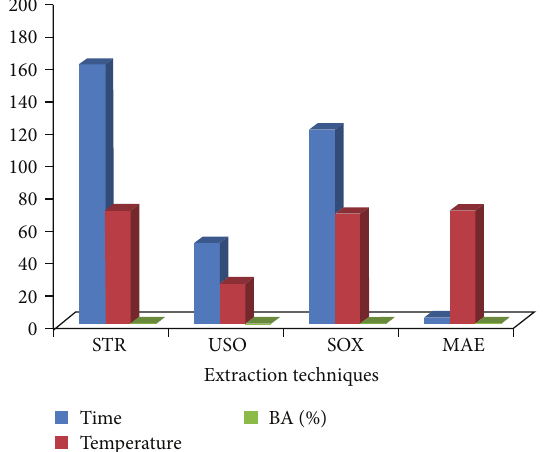
Figure 9: The effect of stirring extraction with methanol at varying pH values.